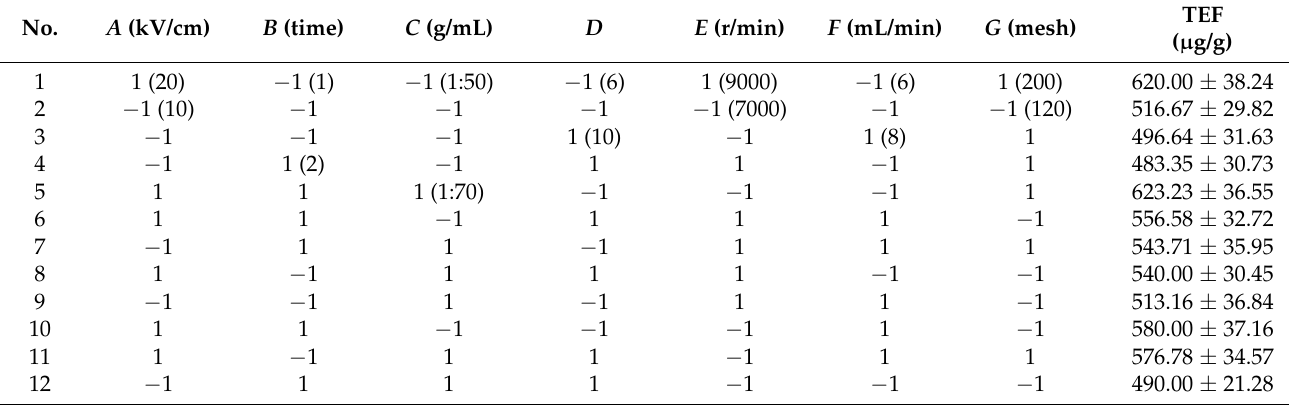
Table 1. Factors and results of